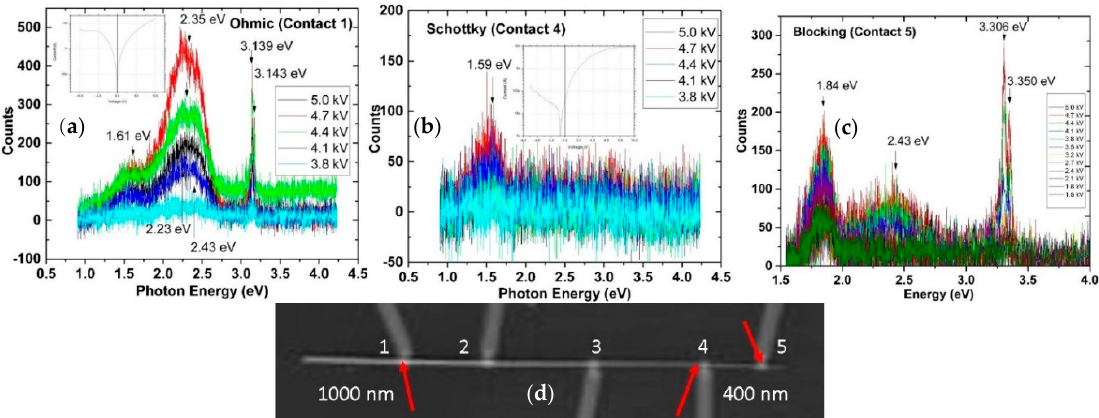
Figure 8. DRCLS of ( a ) ohmic, ( b ) Schottky, and ( c ) blocking contacts on the same ZnO nanowire ( d ) at locations indicated by arrows. Insets in ( a , b ) show ohmic and Schottky I–V characteristics, respectively. Deep level emissions at each contact depend strongly on the wire diameter.